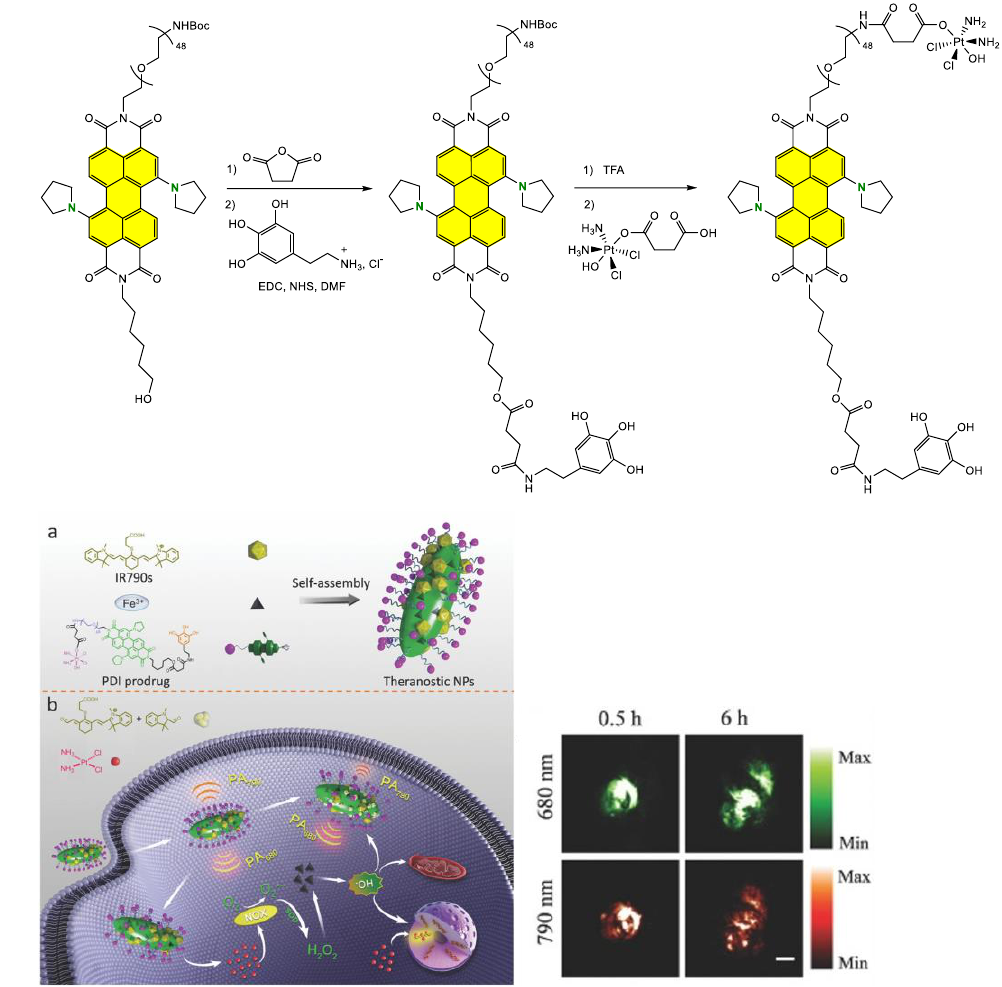
Figure 27. Synthesis of PDI prodrug; ( a ) illustration of the preparation of theranostics by self-assembly of PDI prodrug and IR790s triggered by Fe 3+ , ( b ) mechanism of cisplatin release; PA images of the tumour with local administration of PDI–IR790s NPs. Reprinted with permission from Ref. [138]. Copyright 2018 Wiley-VCH GmbH.